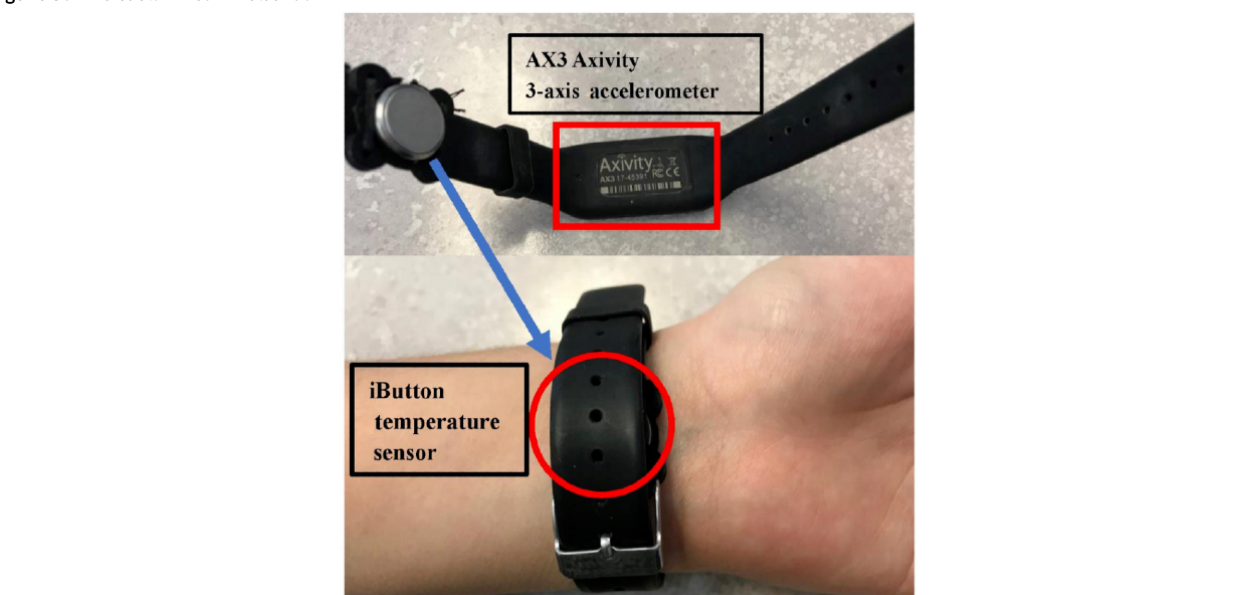
Figure 3. The customized